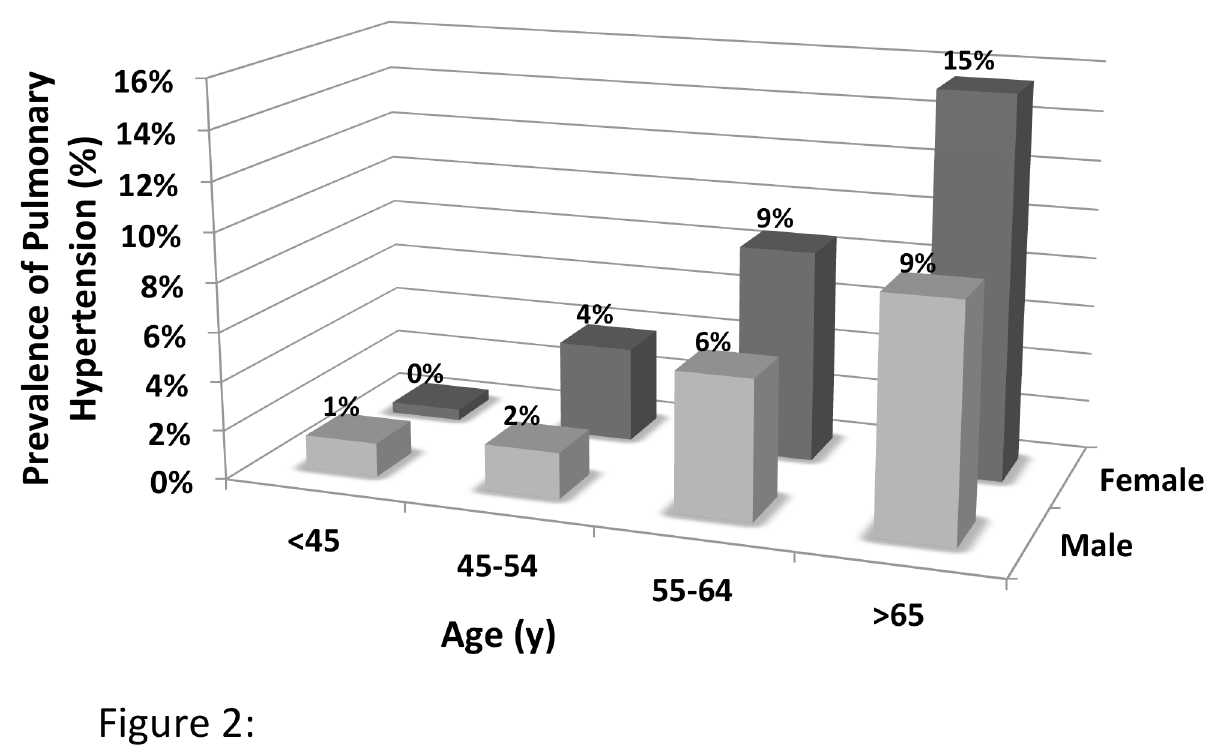
Figure 2. Prevalence of pulmonary hypertension based on age groups and gender. doi: